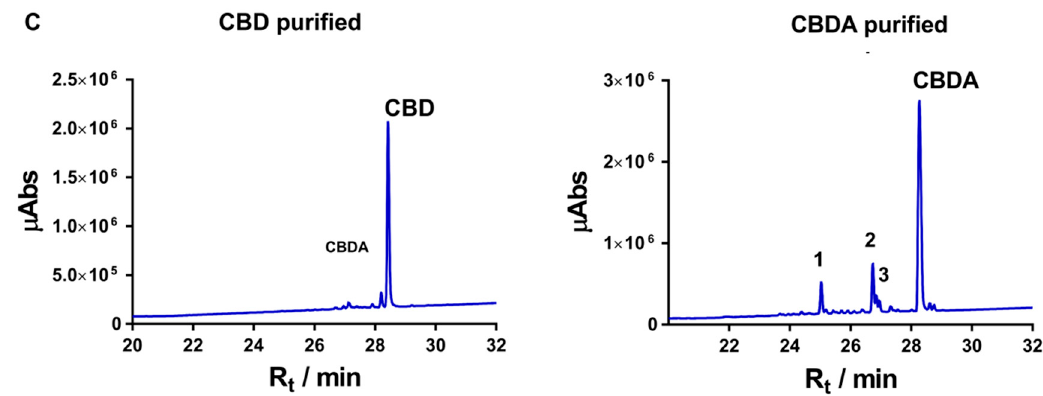
Figure 2. ( A ) HPLC chromatogram of the two cannabis extracts from Canna-Terapeutics and Møllerup Gods. The peaks with retention times (R t ) of 28.4 and 28.2 min correspond to CBD and CBDA and are present in both the standards ( B ) and the purified samples (data not show). ( C ) Purified CBD and CBDA; the samples are run on a semi-preparative column, thus resulting in di ff erent retention times. The LC-UV / vis chromatogram is plotted in λ max (wavelength of maximum absorbance) mode between 225 and 800 nm. Abs: absorbance.